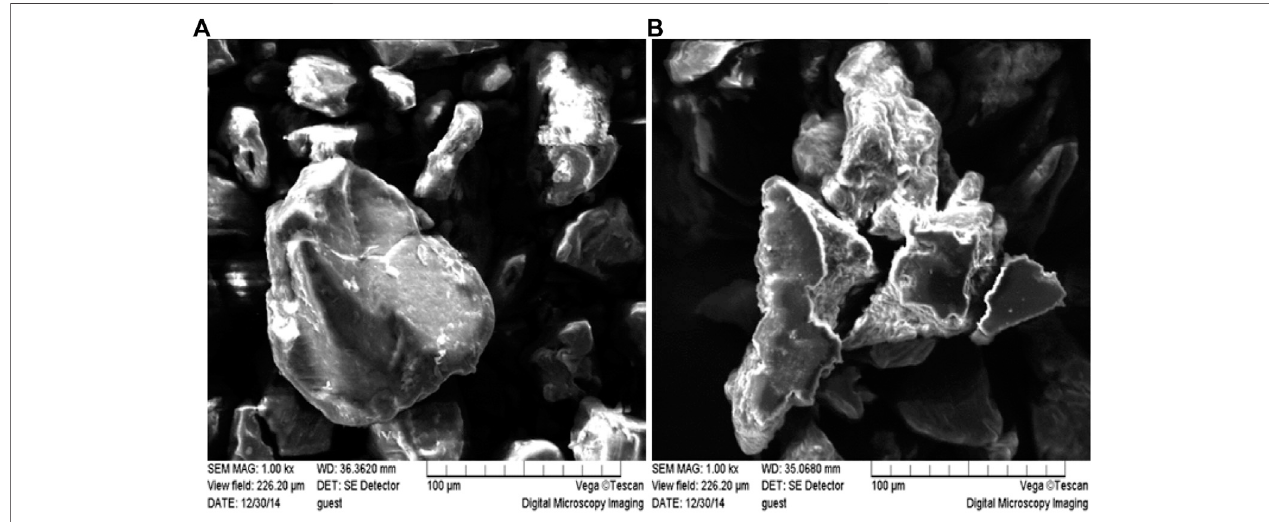
FIGURE 5 | Effects of ultrasound pretreatment of different durations on the microstructure of XAC. (A) Original (0min) non-sonicated XAC; (B) Ultrasound pretreated XAC for 40 min (50 kHz, 0.40 W/cm 2 ).